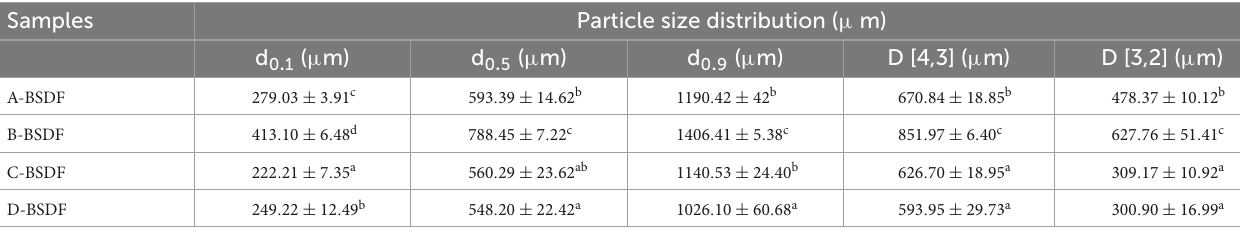
TABLE 2 Particle size distribution of different varieties of bamboo shoot dietary fibers.